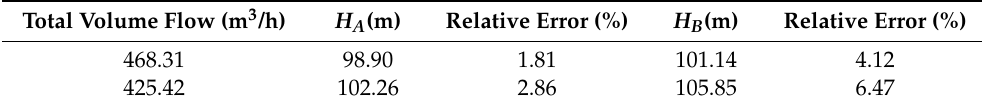
Table 8. Comparisons of converted results from two-stage simulation.